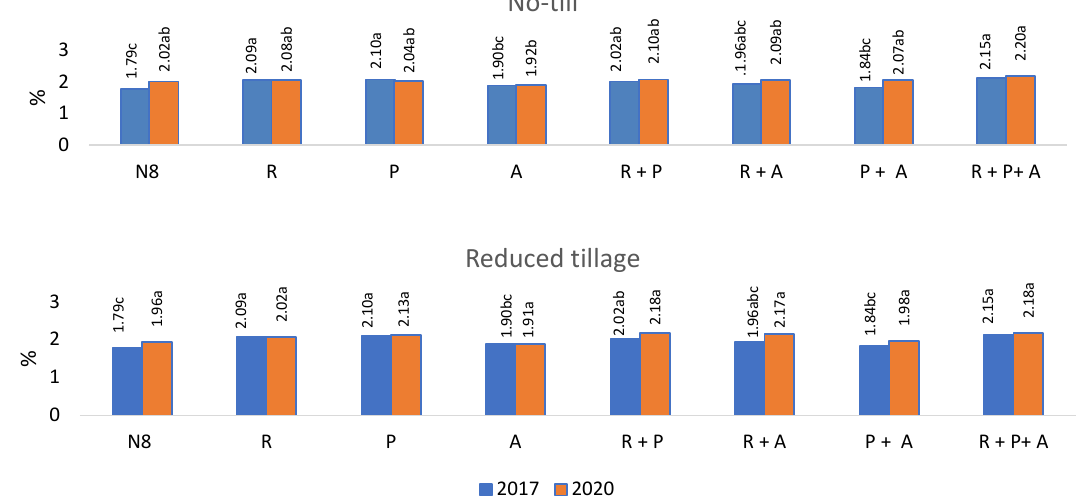
Table 4. The influence of biostimulants and their mixtures on the content of total nitrogen and or- ganic carbon and their ratio in the soil (%).